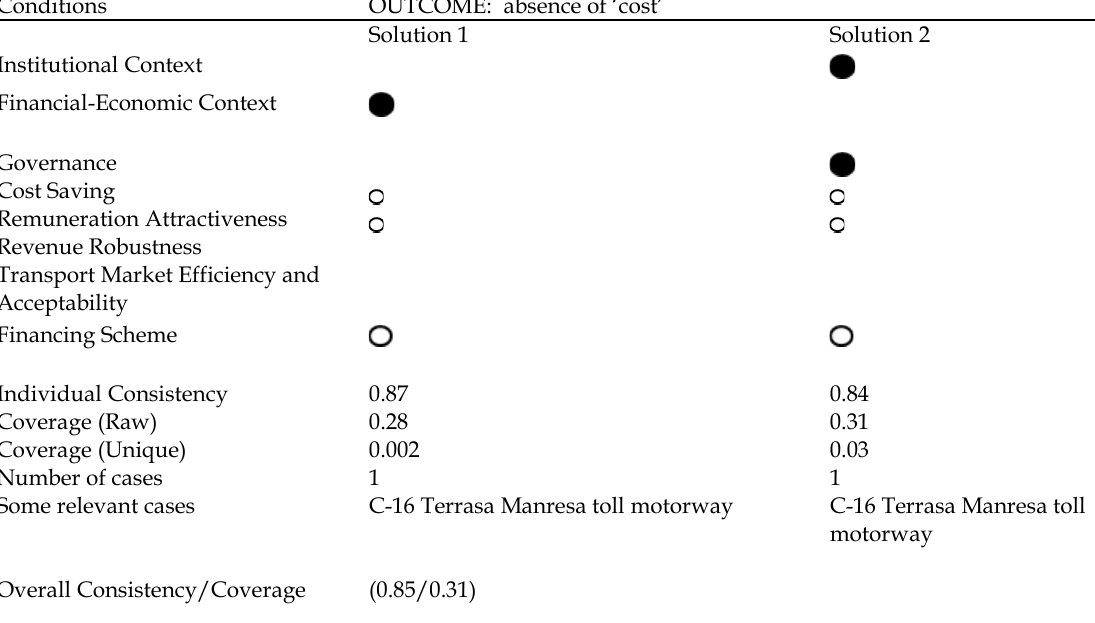
Table 5. Sufficiency analysis of projects being over cost (cut-off: